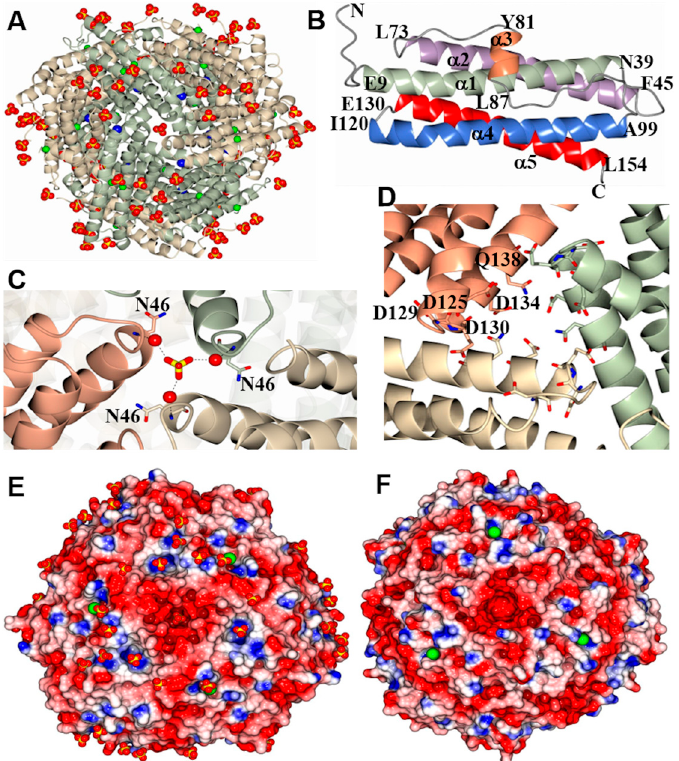
Figure 2. Structure of Pa Dps: ( A ) View of a Pa Dps dodecamer model obtained from Dps-o crystals. Green/wheat ribbons render the dodecamer subunits. Sodium and chloride ions are in blue and green spheres, respectively, and sulfate ions are shown as yellow/red spheres. ( B ) View of a Pa Dps-o subunit illustrating secondary structure elements. ( C ) View of one of the A-type three-fold pores formed by the convergence of three subunits (wheat, salmon, and green); the sulfate ion is in yellow/red sticks, and water molecules are depicted as red spheres. ( D ) View of one of the B-type three-fold pores (wheat, salmon, green) and negatively charged residues lining the pore interior (residues are noted for one of the subunits). Electrostatic surface representation of an A-type pore ( E ) and a B-type (ferritin-like) pore ( F ) in Pa Dps-o; the sulfate ions (yellow/red) and chloride ions (green) are rendered as spheres. Units are in volts from − 0.5 (red) to +0.5 blue. The Dps-c structure is nearly identical to the Dps-o structure, as indicated by the 0.38